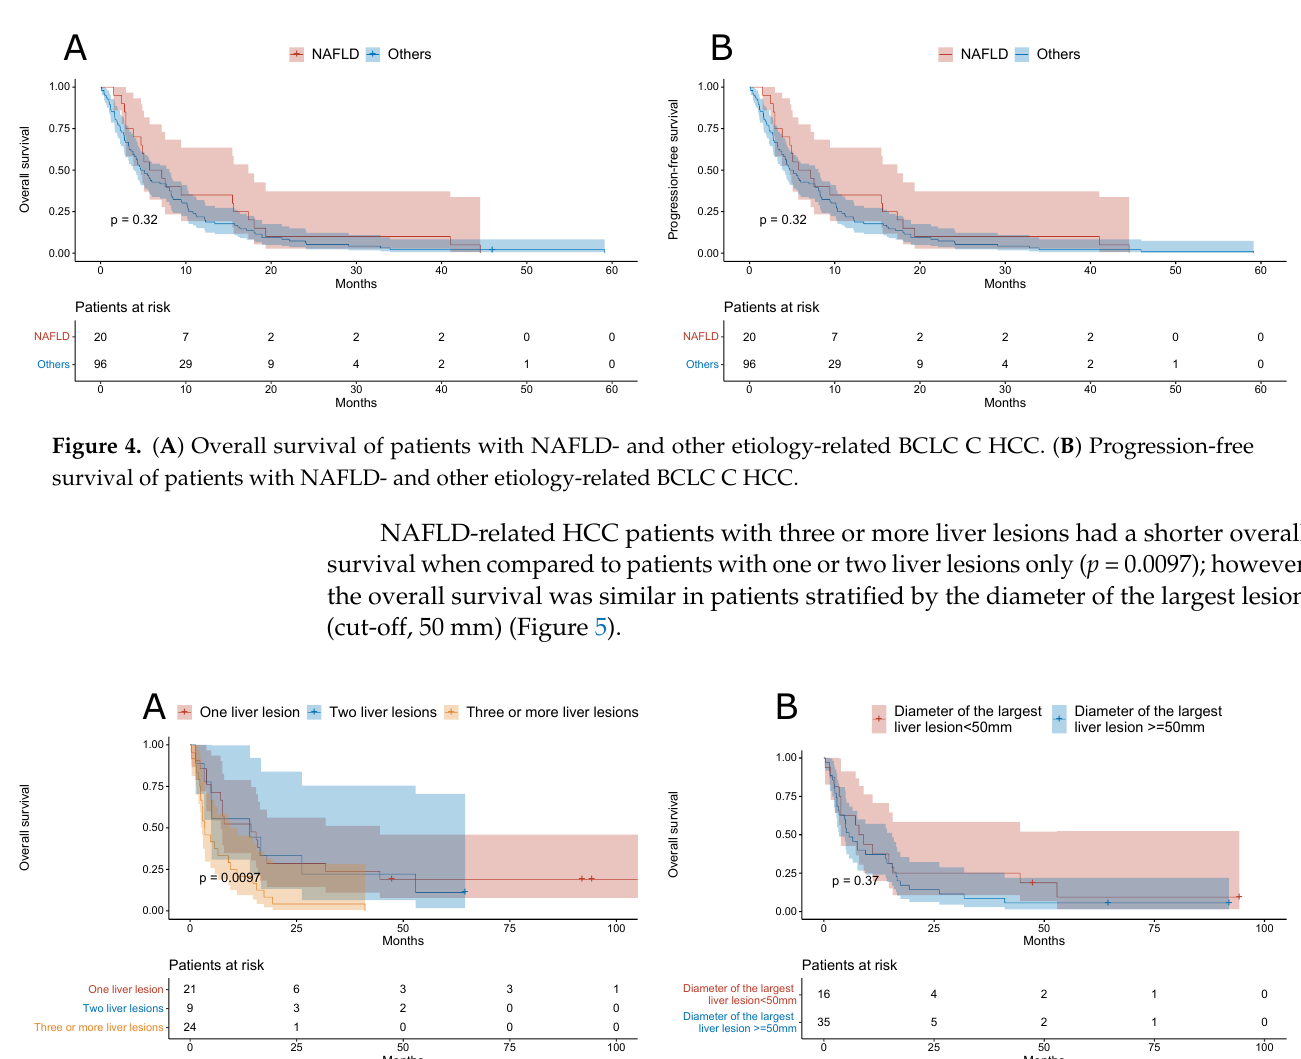
Figure 3. ( A ) Overall survival of patients with NAFLD- and other etiology-related BCLC B HCC. ( B ) Progression-free survival of patients with NAFLD- and other etiology-related BCLC B HCC.